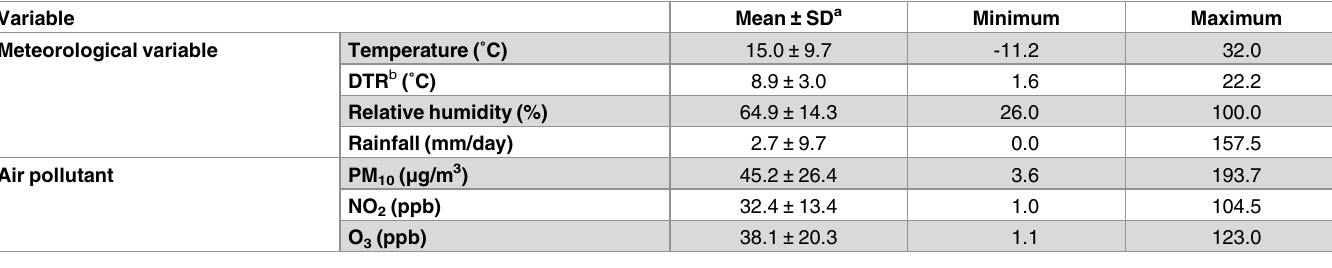
(95% CI: 10.5, 15.2) decrease in AD symptoms on the same day (Table 3). A statistically signifi- cant association was also found between a decrease in AD symptoms and an increase in vari- ous moving averaged temperatures. Similarly, an increase in outdoor RH by 5% decreased the risk of AD symptoms from 3.3% (95% CI: 1.7, 4.8) with MA0 to 5.4% (95% CI: 2.9, 7.8) with MA0-5. This finding reflects the protective effect of elevated outdoor RH on AD. The effect was stronger as the number of moving average days increased, indicating that there was a lag effect. An increase in DTR of MA0-4, i.e. moving average of the previous 4 days and the cur- rent day, by 5˚C increased AD symptoms by 10.6% (95% CI: -3.1, 26.2), but not significantly. Of note, we found that AD symptoms increased by 284.9% (95% CI: 67.6, 784.2) per 5˚C increase in DTR when we fitted for the data > 14˚C DTR in the GLMM after controlling for the same confounders. A daily rainfall increase by 5 mm/day was significantly associated with an increase in AD symptoms by 2.2% (95% CI: 0.4, 4.1) on the same day. When we fit the same model for the daily rainfall data < 40 mm/day, the effect size of rainfall increased to 7.3% (95% Table 2. Summaryof meteorological variables and air pollutant levels during the study